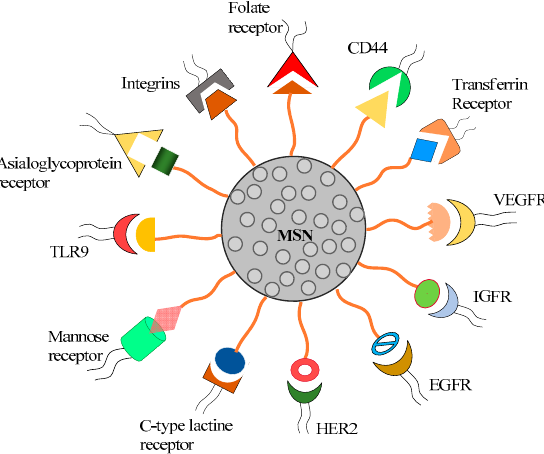
Figure 1. Plausible surface modifications of mesoporous silica nanoparticles (MSN) for active targeting to the over-expressed receptors in cancer microenvironment.